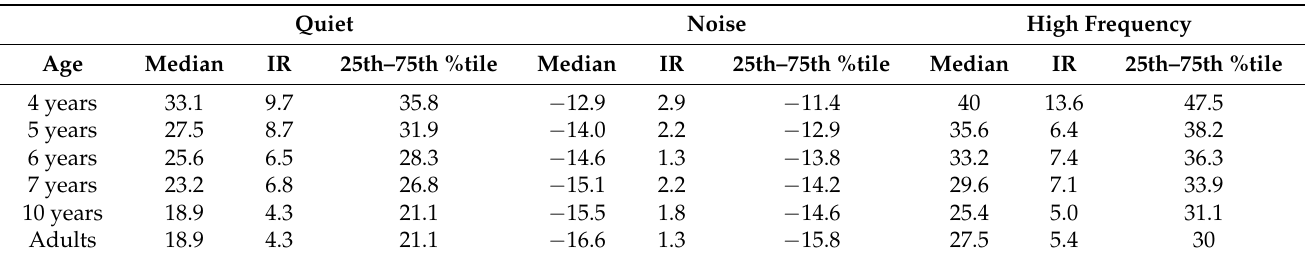
Table 2. Median and Interquartile Range Percentiles in Quiet, Noise and High Frequency across age